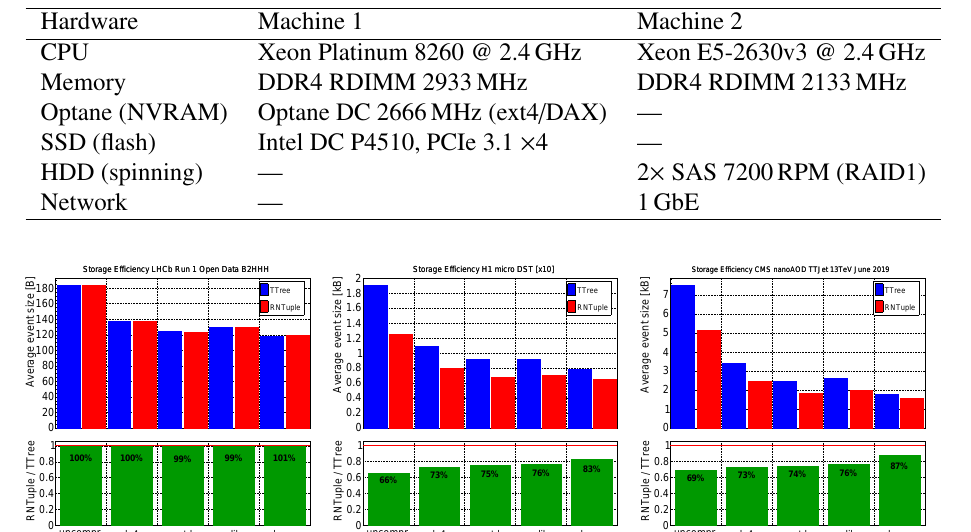
Table 2. Overview of the benchmarking hardware.